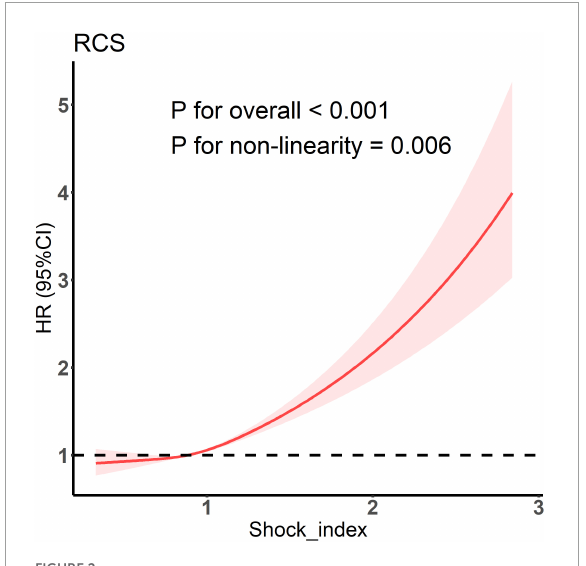
FIGURE2 Restricted cubic spline model showing association between shock index and the occurrence of in-hospital death.